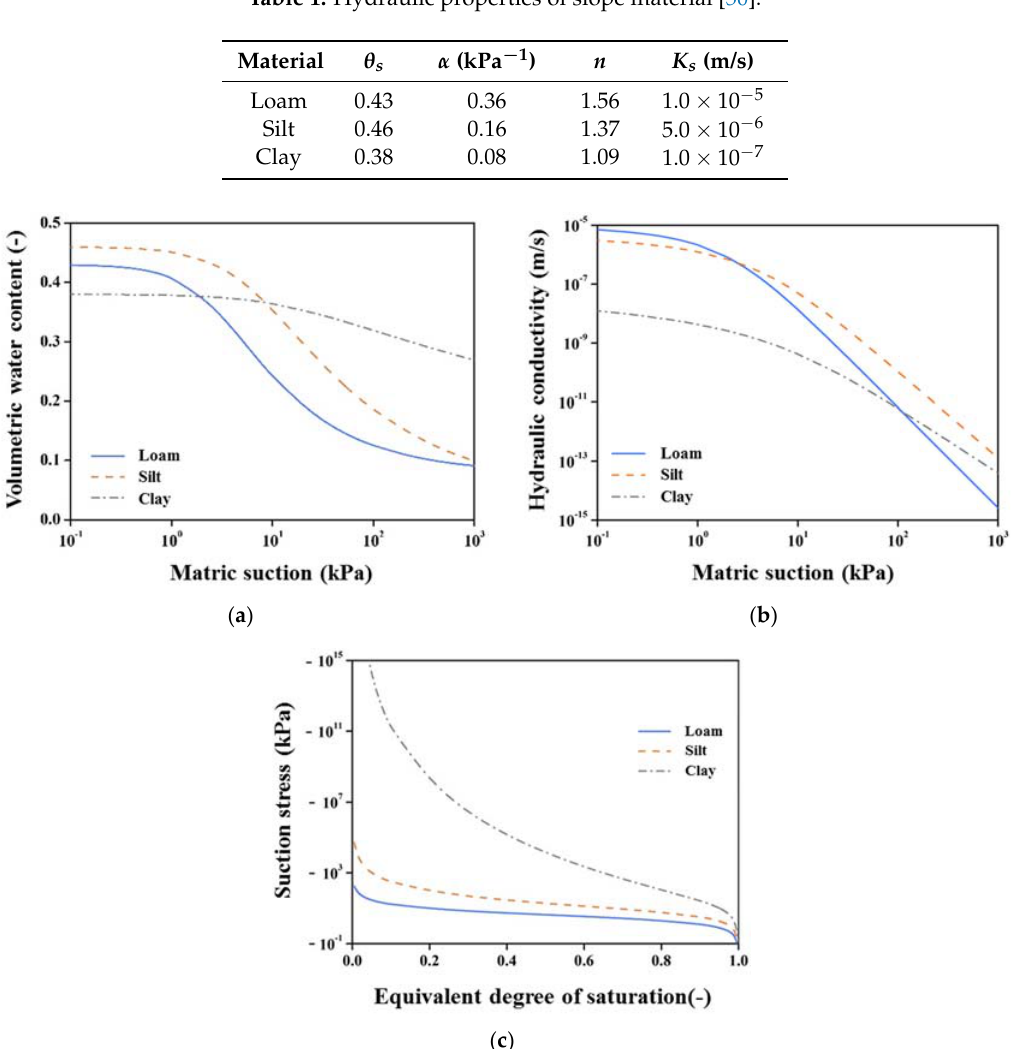
Figure 3. Hydraulic properties of slope material. ( a ) Soil water retention curve (SWRC); ( b ) Hydraulic conductivity function (HCF); ( c ) Suction stress characteristic curve. Table 2. Mechanical properties of slope material [51].